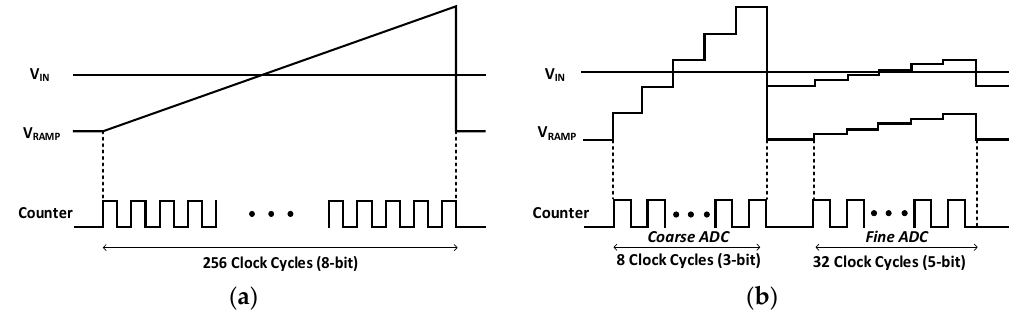
Figure 5. Operation principle of ( a ) SS ADC and ( b ) TSSS ADC.